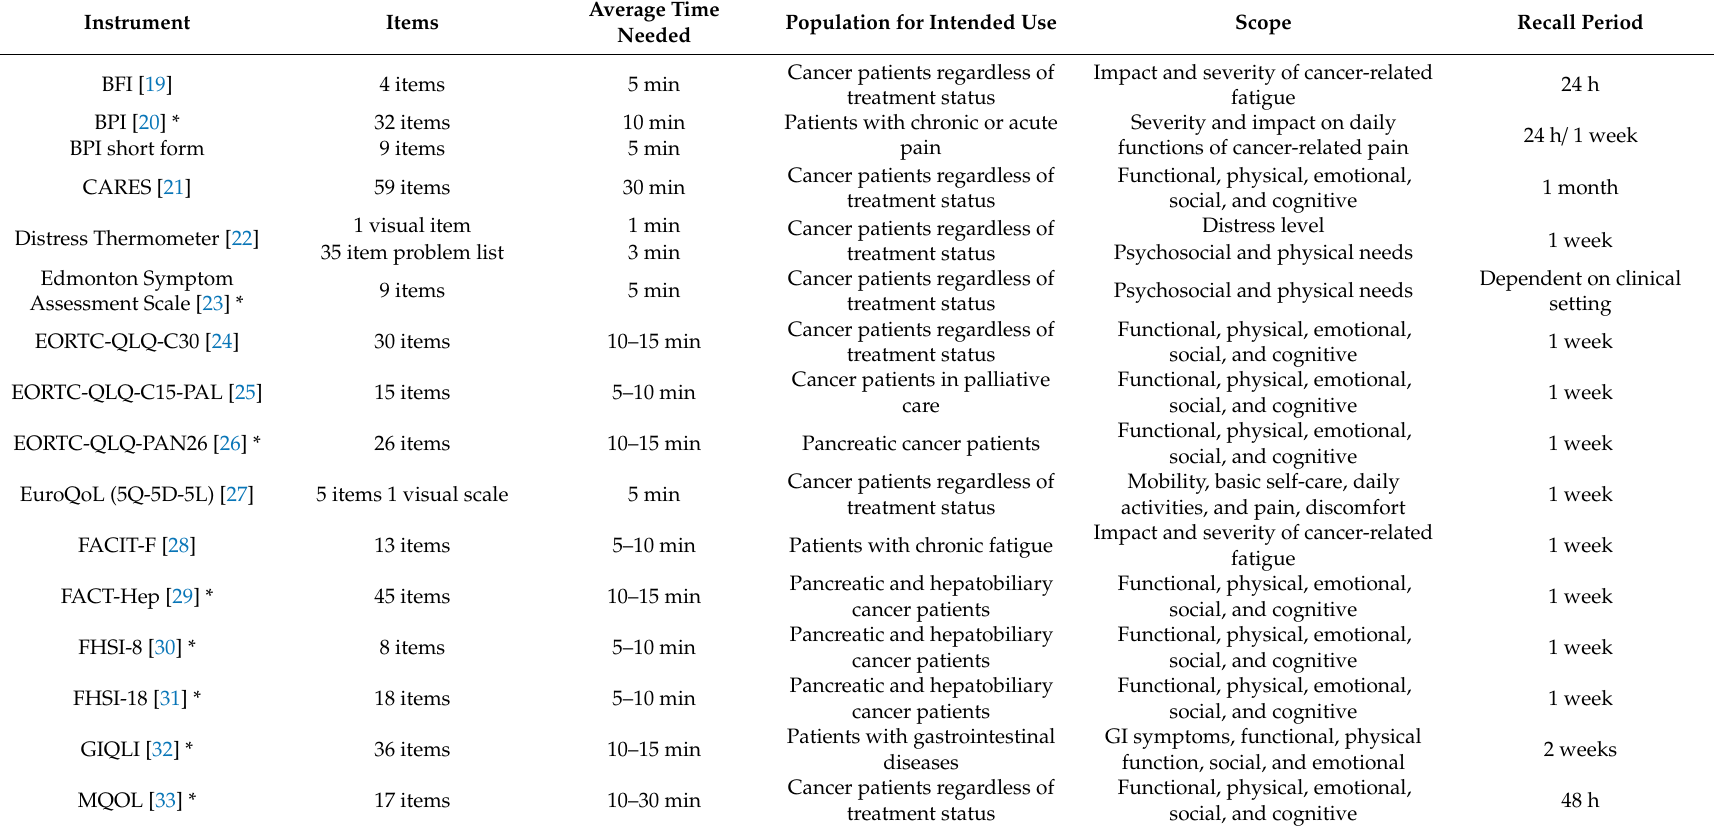
Table 1. Patient-reported outcome (PRO) instruments available for use in pancreatic